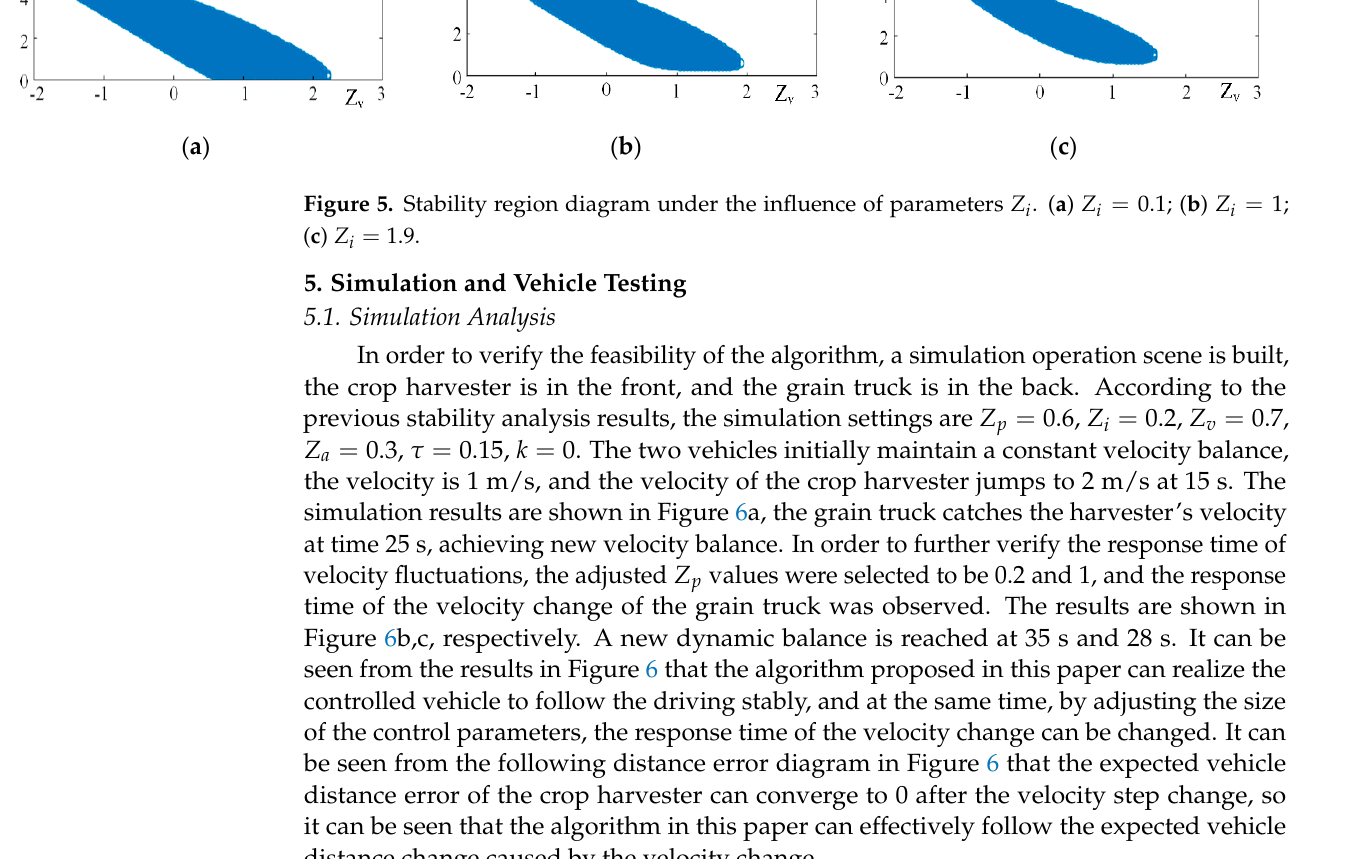
8 of 15 Figure 4. Stability region diagram under the influence of parameters a Z . ( a )